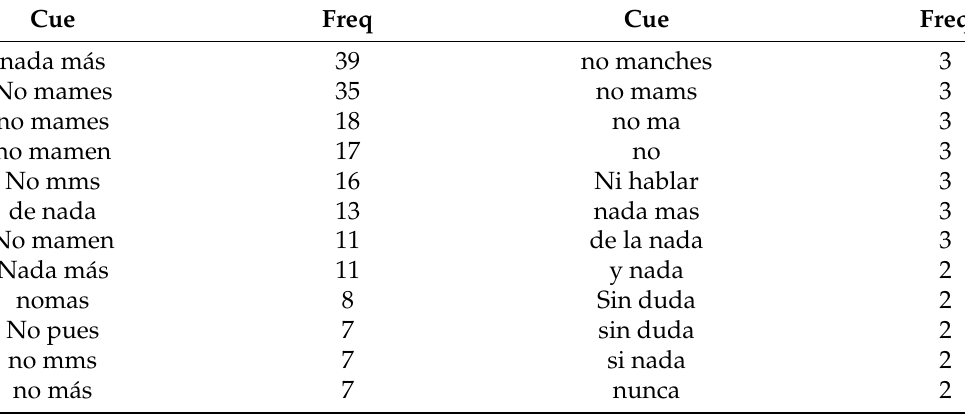
Table A5. Distribution of the negation cues that were considered as false negation in the corpus. The items that appear in the table have more than one